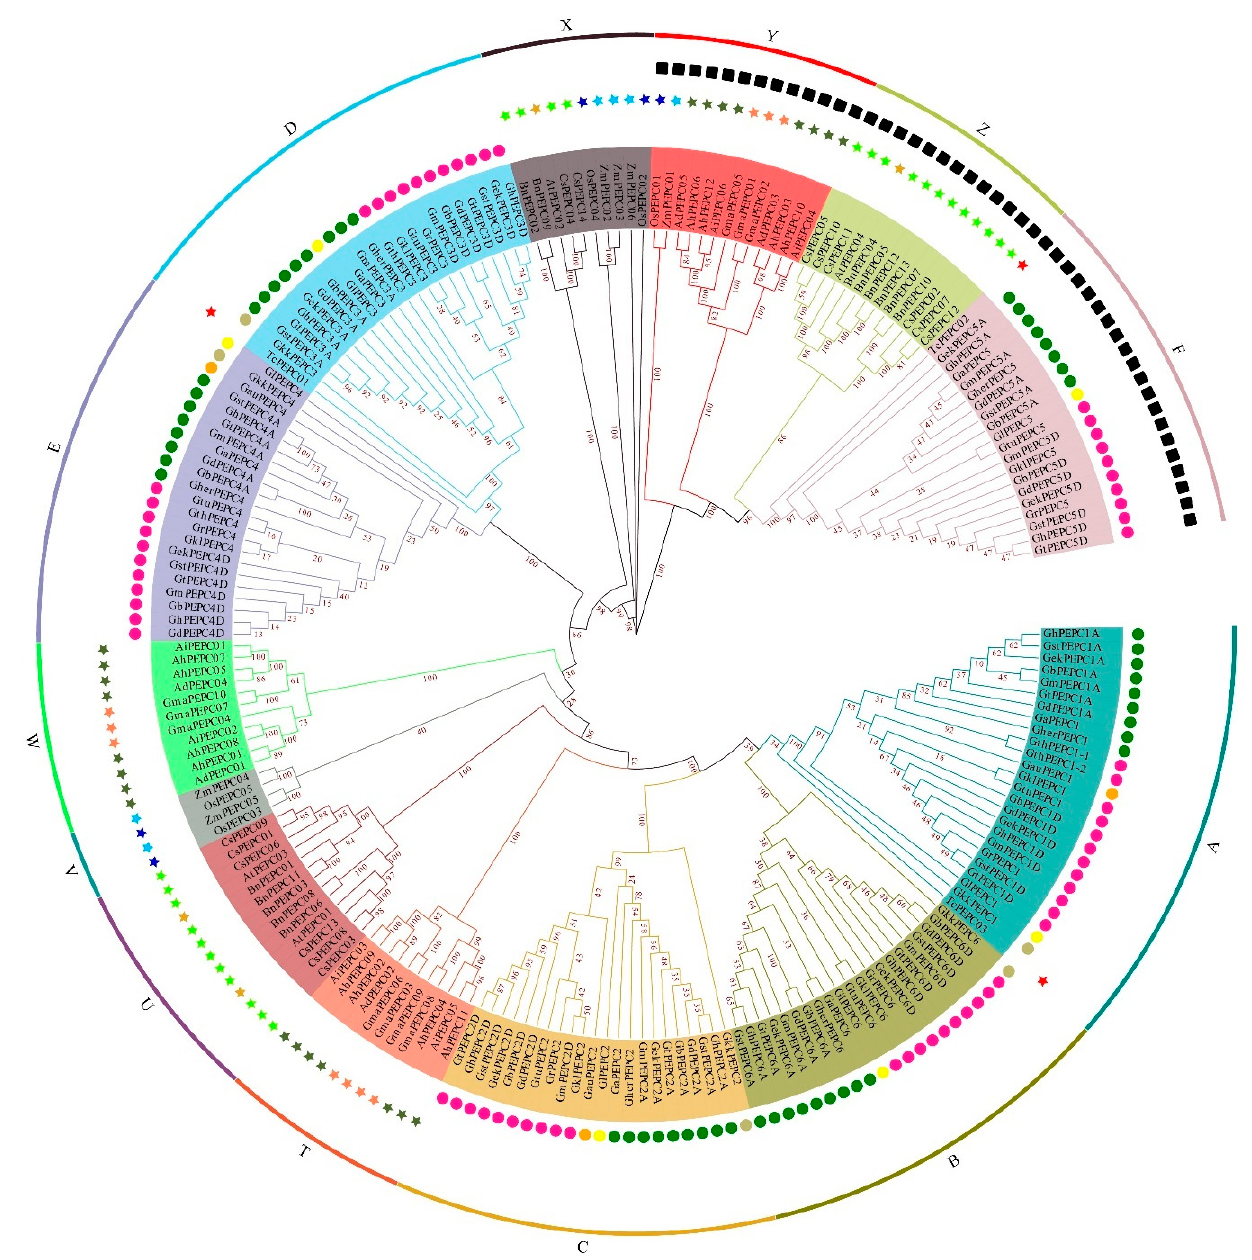
Figure 2. Phylogenetic tree of PEPC proteins from total 26 species. Different colored lines and regions indicate PEPC protein scores in different groups. The arcs of different colors indicate different groups of PEPC proteins. Cotton is in the A–F group, and other species are in the X, Y and Z groups. The figure contains two circles of symbols, the inner circle is to divide all cotton PEPC proteins by genome, and the outer circle is the PEPC proteins of other species divided by species. These PEPC proteins are classified into different subgroups (A, B, C, D, E, F, T, U, V, W, X, Y, and